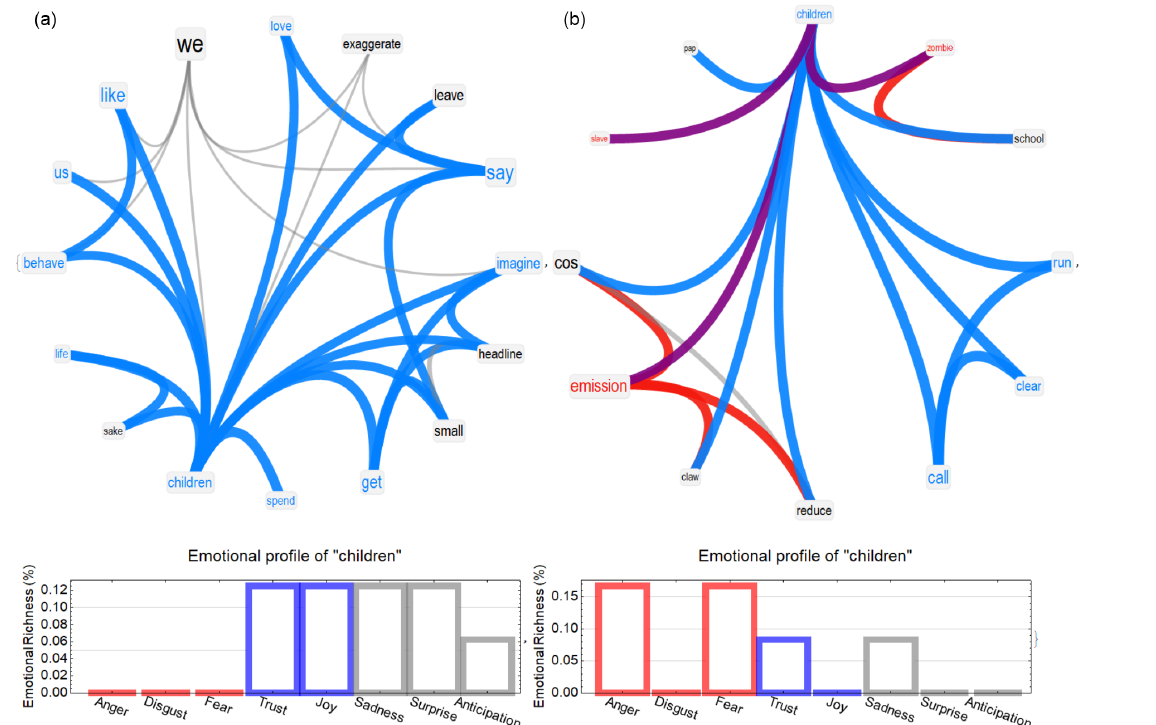
Figure 2. Speakers’ mindset reconstruction around “Children” in the speeches of Greta Thunberg (a) and Christopher Monckton (b) . We refer the reader to Fig. 1 for a detailed explanation of the colour code and to Lexicon 1 for an interpretation of the